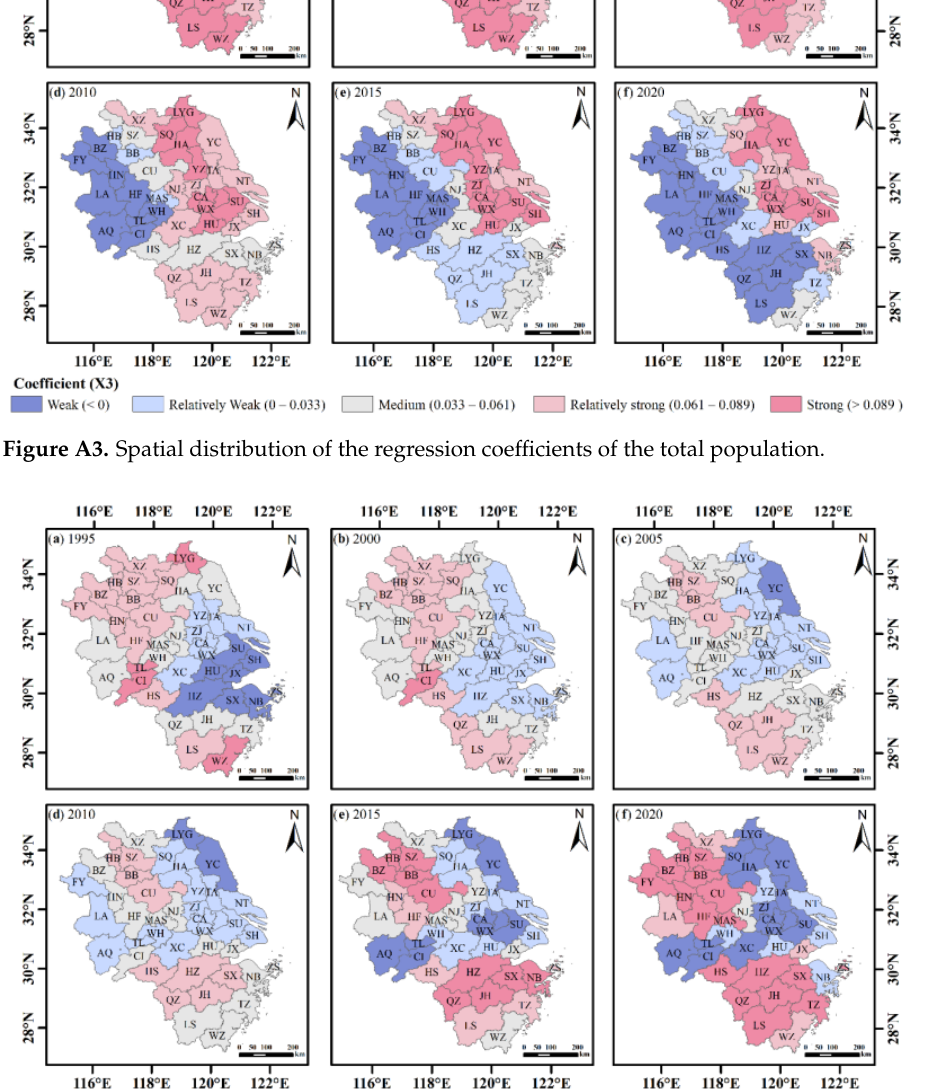
Figure A4. Spatial distribution of the regression coefficients of the population urbanization.